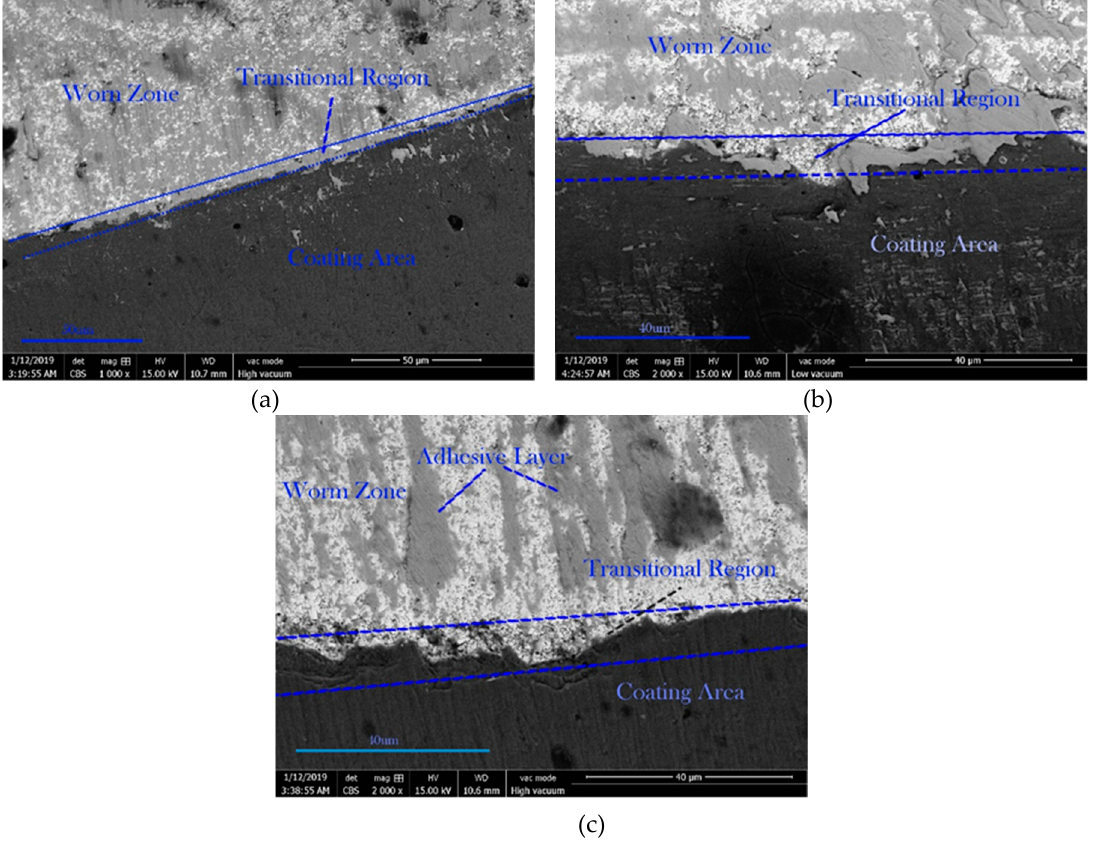
Figure 7. Back-scattered electron imaging. ( a ) The coating condition of the tool surface at 150 m/min; ( b ) The coating condition of the tool surface at 200 m/min; ( c ) The coating condition of the tool surface at 250 m/min.